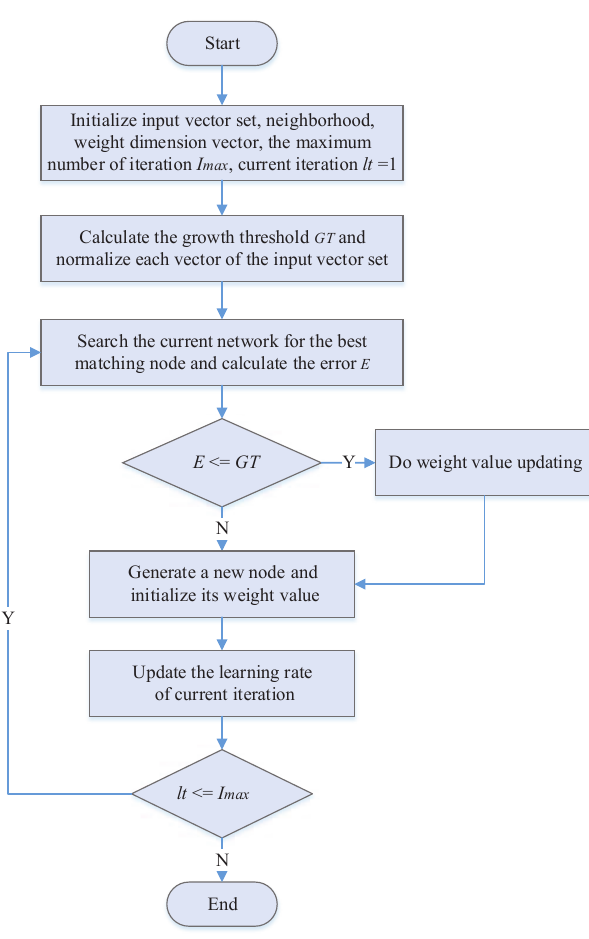
Figure 4. Flowchart of ODSOFM